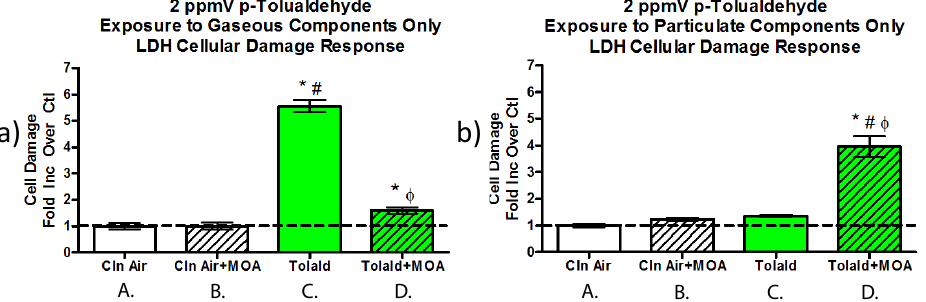
Fig. 5. Cellular damage following exposure to four air mixtures. The response induced by exposure to (a) the gaseous components of each mixture and (b) the particle-phase components of each mixture.